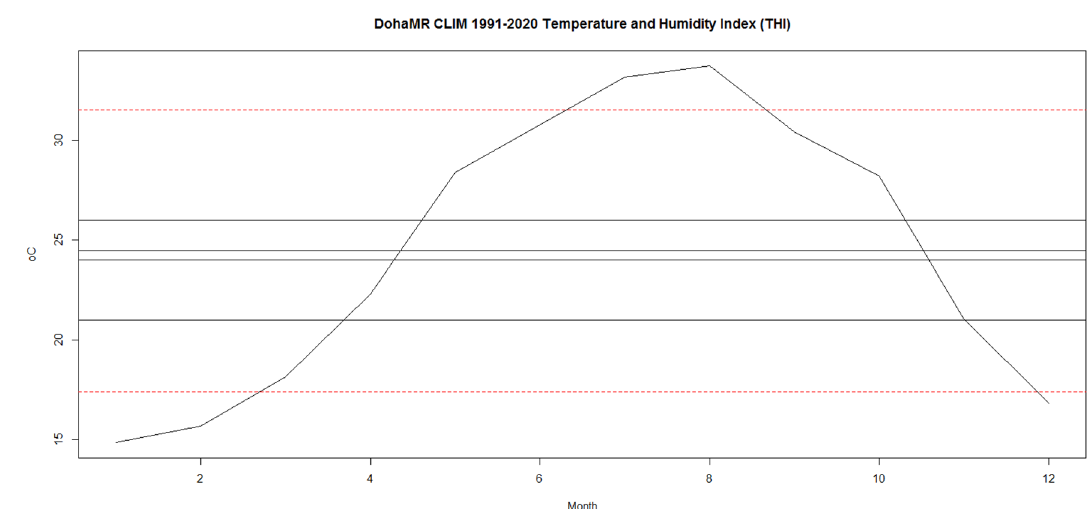
Fig. 2 Temperature and Humidity Index (THI) for the Doha Metro- politan Region, current climatology, 1991–2020, represented by a LOESS (local regression or local polynomial regression) curve